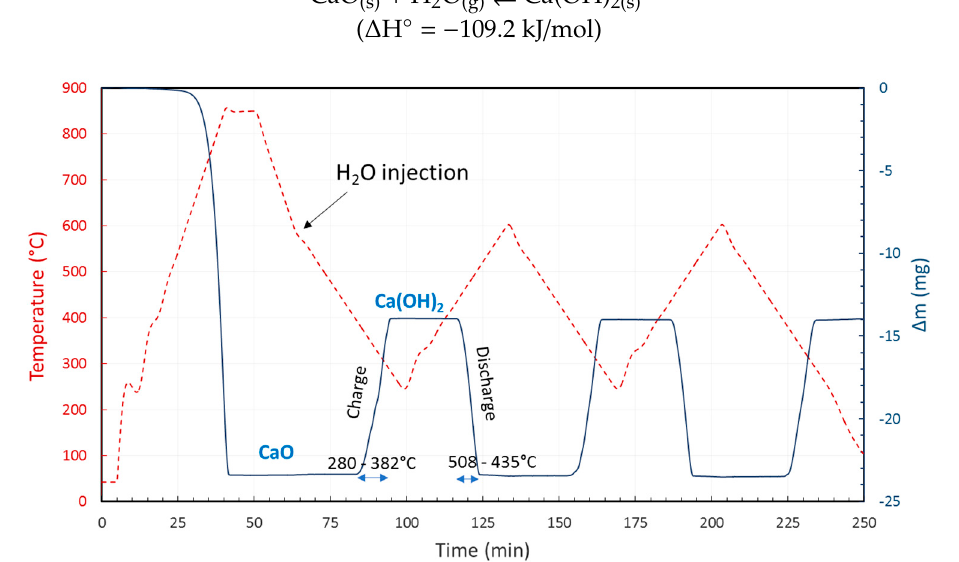
Figure 3. TGA of CaO / Ca(OH) 2 showing excellent reversibility during charge / discharge cycles under 21 mol% H 2 O (g) . CaO was first obtained from calcination of commercial CaCO 3 to CaO at 850 °C under pure Ar.